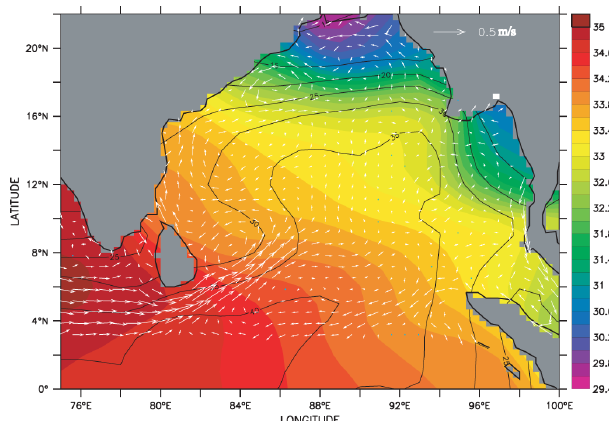
Figure 6. Mean surface salinity (psu, shading) overlaid with geostrophic current (ms − 1 , white vectors) derived from mean sea level anomaly and mixed layer depth (m, black contours) for the period